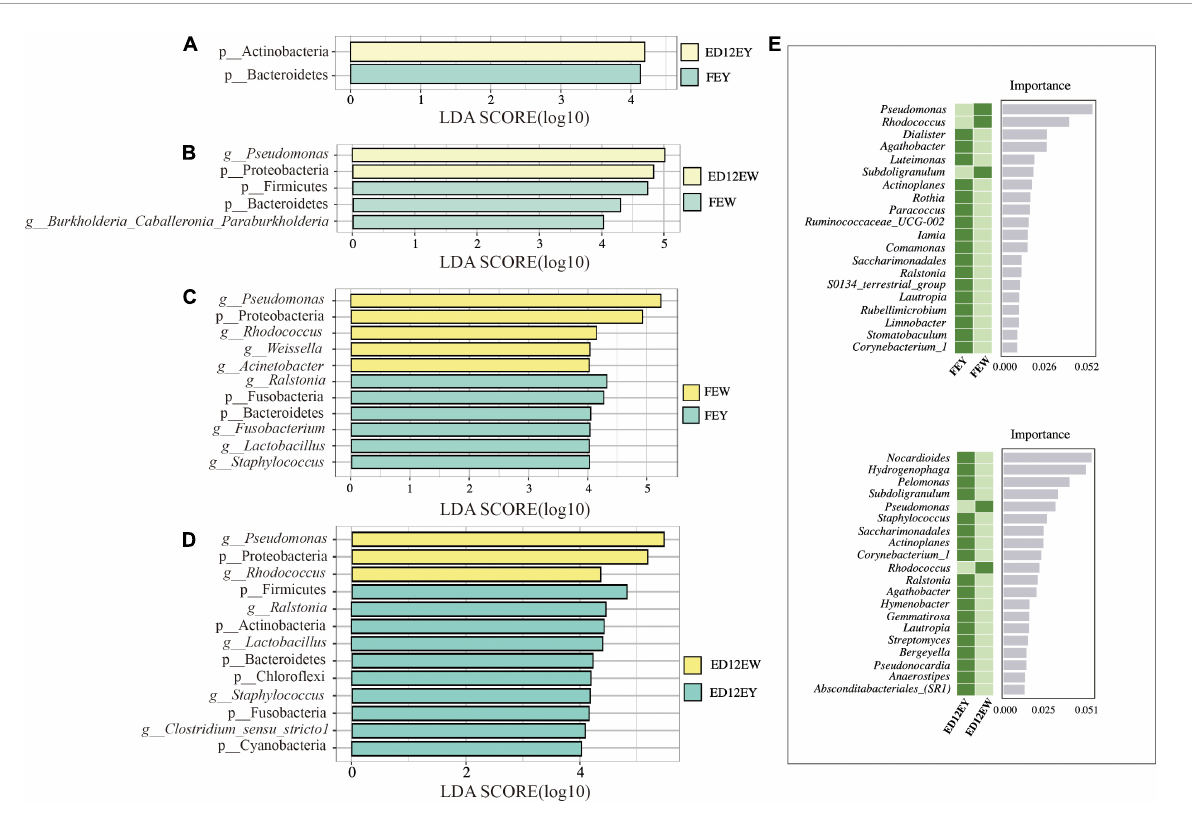
FIGURE5 LEfSe results for the egg white and yolk. LEfSe analysis was used with an LDA score > 4.0 to show differential enrichment of the bacterial features as biomarkers between egg yolks and whites in different groups. (A,B) LEfSe shows the differential microbiota between fresh egg yolks and whites. (C,D) LEfSe shows the differential microbiota between egg yolks and whites at 12 embryonic ages. (E) Random forest analysis identifies the key differential genera between egg yolks and whites at different